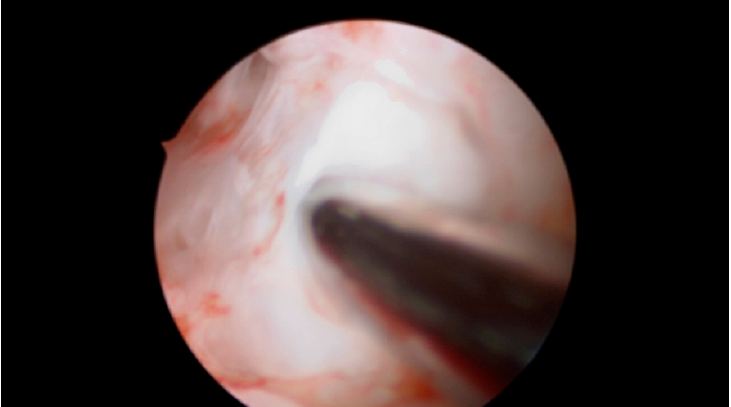
Figure 3. The markings on the ovum pickup needle help to determine the correct depth of insertion.